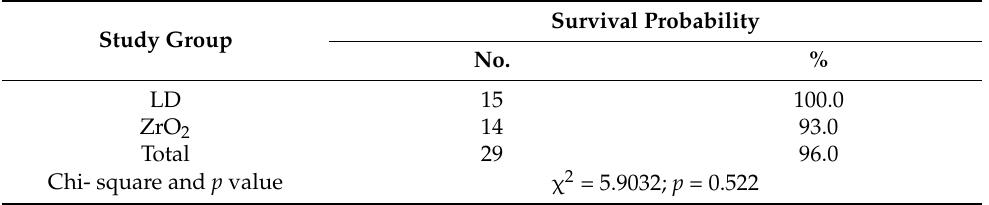
Table 4. The survival probability in the study groups.